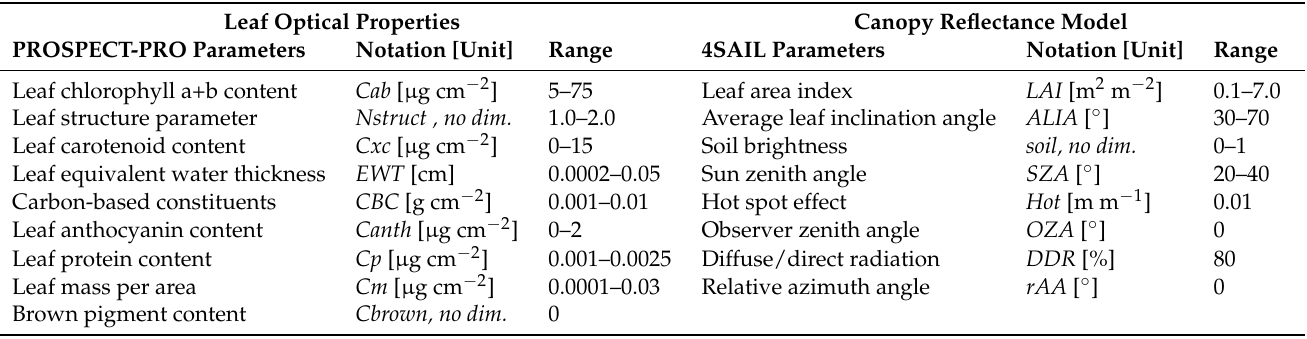
Table 1. Parameter ranges for PROSPECT-PRO and 4SAIL (PROSAIL-PRO). Specified ranges are uniformly distributed in LHS